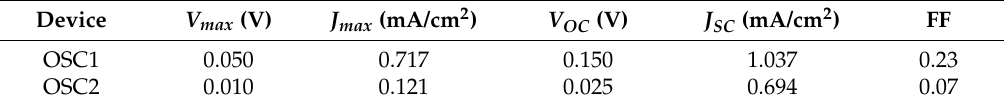
Figure 8. J - V characteristics of ( a ) OSC1 and ( b ) OSC2. Table 2. Characteristic parameters of the organic solar cells